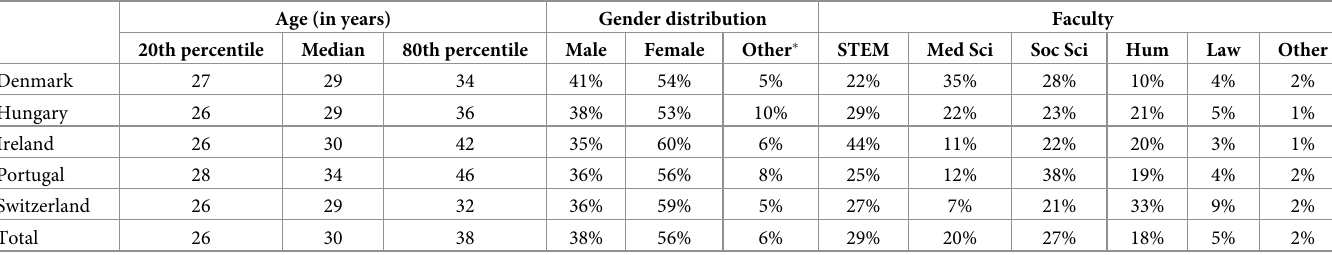
Table 2. Participants’ distribution across gender, age and academic field—Per country and total. Age (in